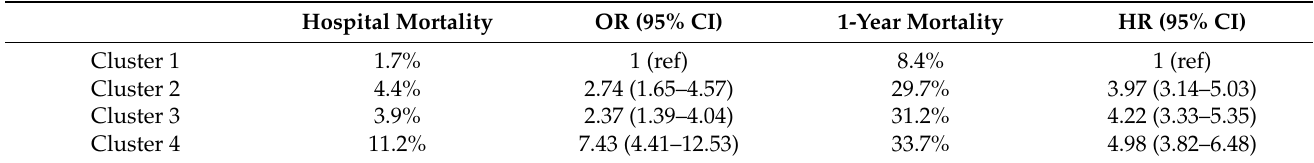
Table 2. Mortality outcomes according to